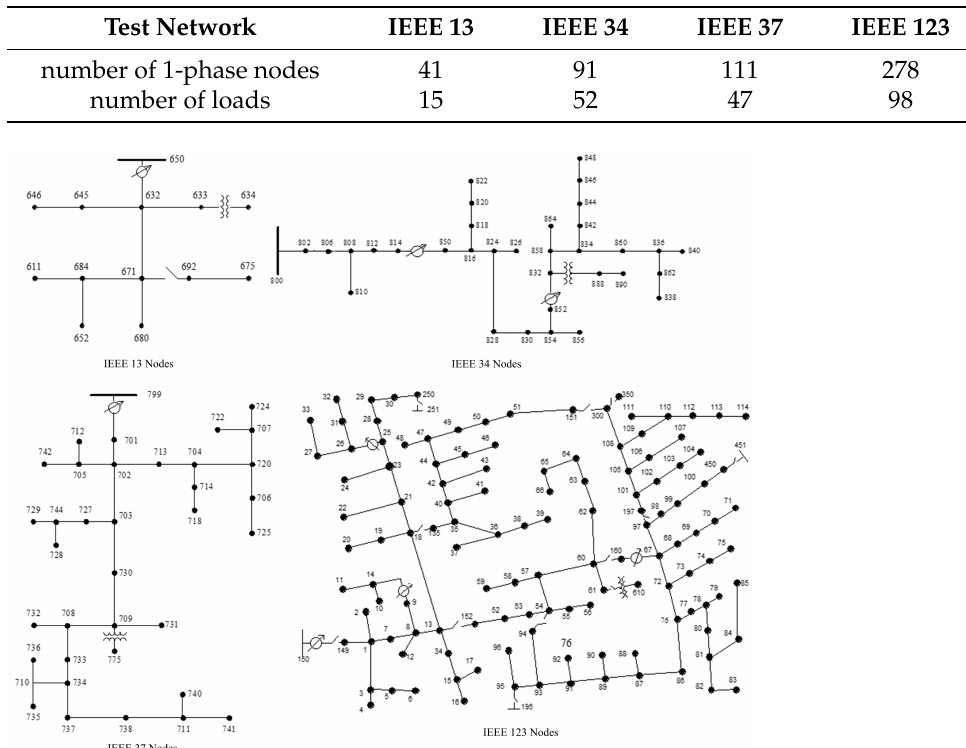
Table 1. Numbers of the network nodes and loads for the tested networks.